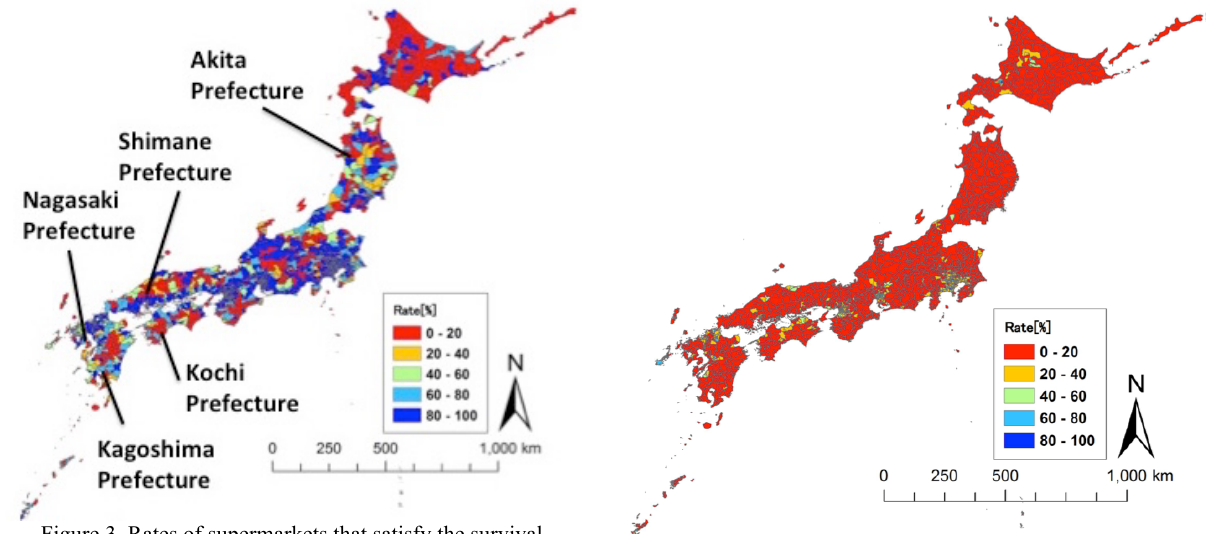
Figure 6. Rates of convenience stores that satisfy the survival conditions in 2010